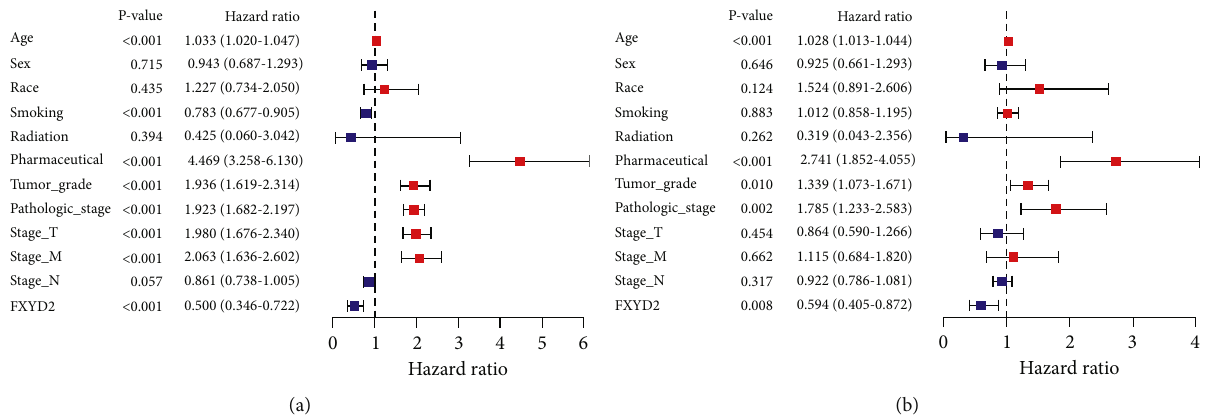
Figure 3: Independent prognostic analysis of FXYD2 in TCGA cohort. (a) Univariate cox regression analysis of FXYD2 in TCGA cohort. (b) Multivariate cox regression analysis of FXYD2 in TCGA cohort. Red square indicates HR larger than 1, while blue square indicates HR smaller than 1. HR: hazard